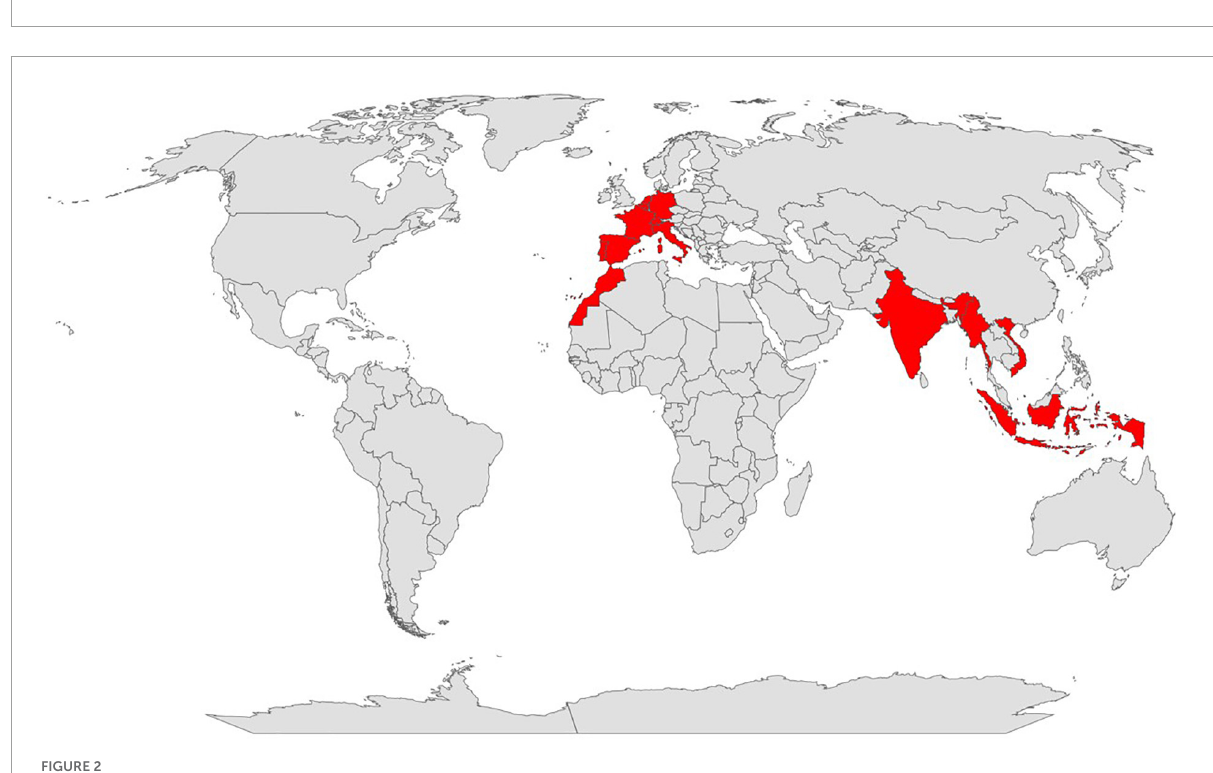
FIGURE2 Distribution map of Piper cubeba